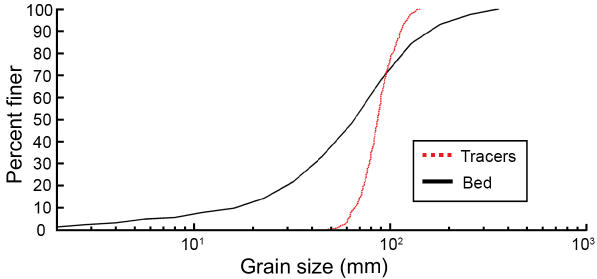
Figure 4. Grain-size distribution of tagged tracers (red) and streambed (black) composite over all study